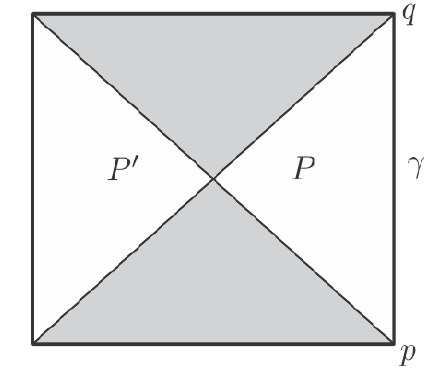
Figure 1 . The Penrose diagram of de Sitter space. An observer enters at the point p at past infinity and exits at the point q at future infinity. Coordinates can be chosen to put these points at corners of the diagram, as shown. The observer’s worldline is a timelike curve γ from p to q , such as the geodesic from p to q , shown here as the vertical line on the right boundary of the diagram. P is the static patch of this observer, and P 0 is the complementary static patch, spacelike separated from P . The shaded regions are behind past and future horizons for an observer in either P or P 0